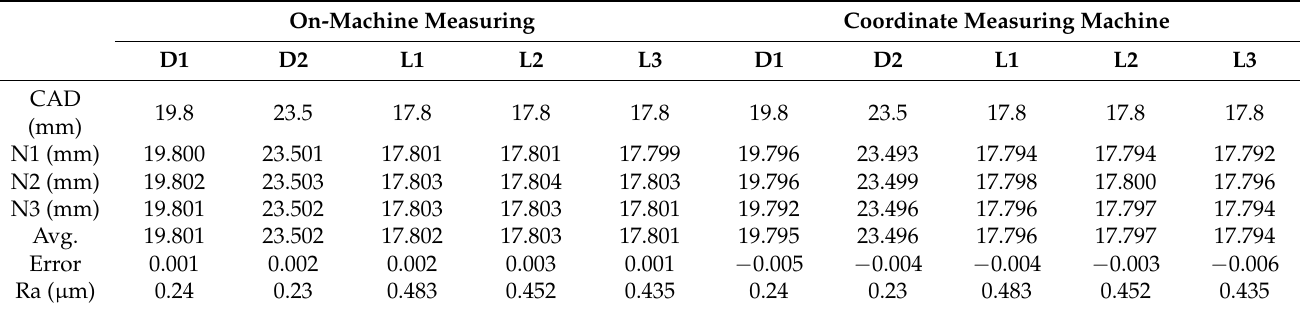
Table 4. Comparison table of measurement between OMM (after probe calibration) and CMM. On-Machine